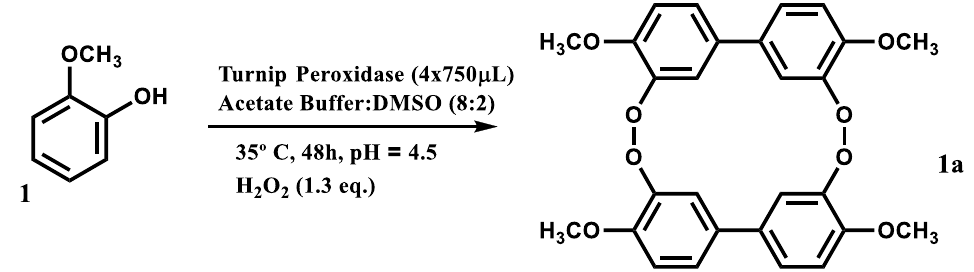
Figure 6. Peroxidase-catalyzed transformation of guaiacol ( 1 ) to tetraguaiacol ( 1a ).